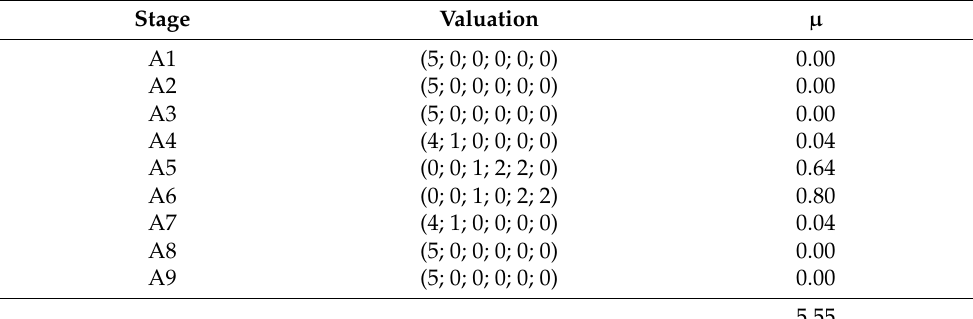
Table 11. Valuation of the situation with regard to the base year (year